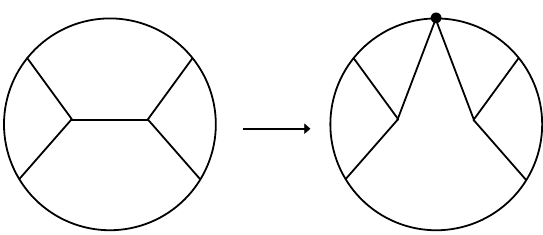
Figure 15. A convenient way to evaluate an exchange Witten diagram is to make use of the split-representation of the bulk two-point